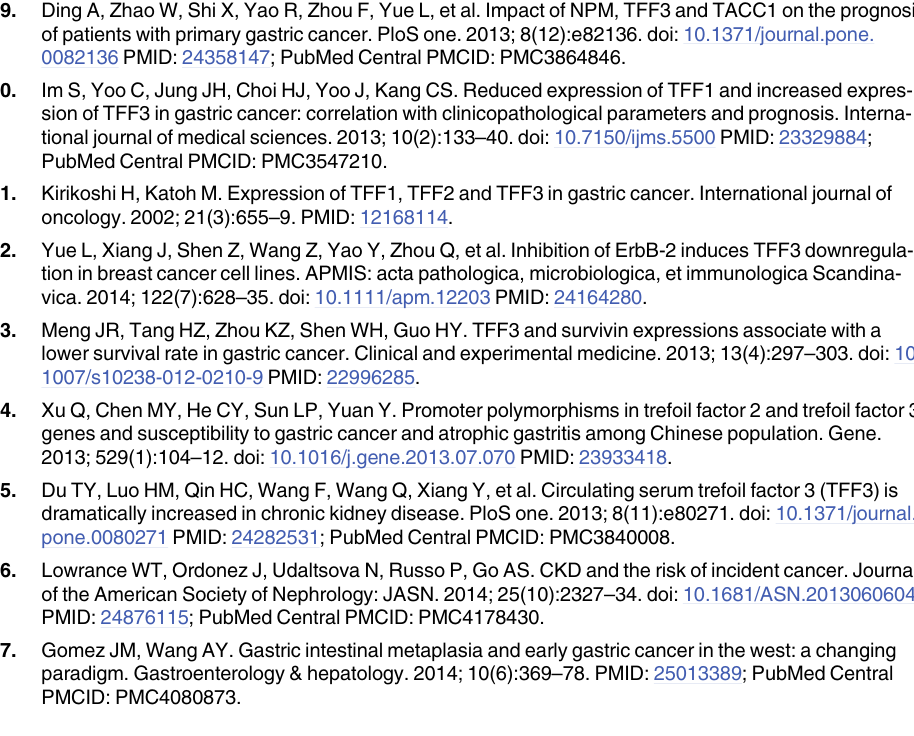
PLOS ONE | DOI:10.1371/journal.pone.0126924 June 17,